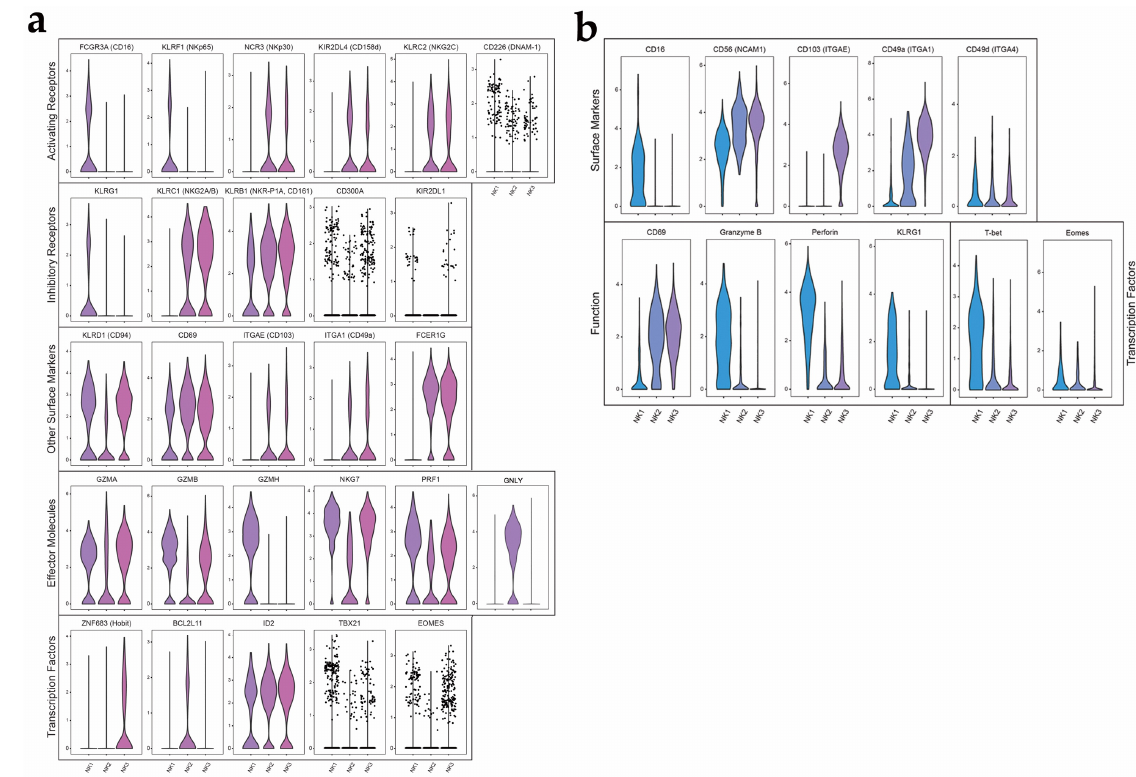
Figure 3. NK cell subset by single-cell RNA sequencing and mass cytometry: ( a ) Expression levels of selected markers in NK cell subsets (scRNA-seq). The expression levels of groups of genes that represent activating receptors, inhibitory receptors, effector molecules, transcription factors and other surface markers are shown; ( b ) The expression levels of certain surface markers, NK cell function-related markers and transcription factors by mass